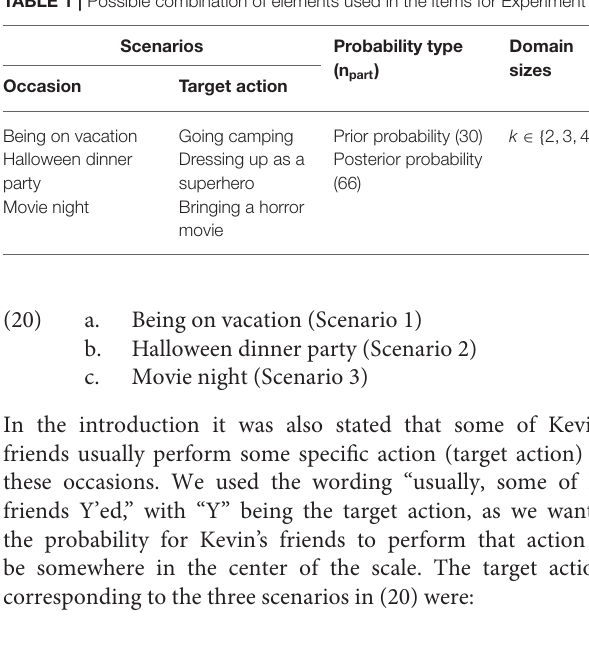
TABLE 1 | Possible combination of elements used in the items for Experiment